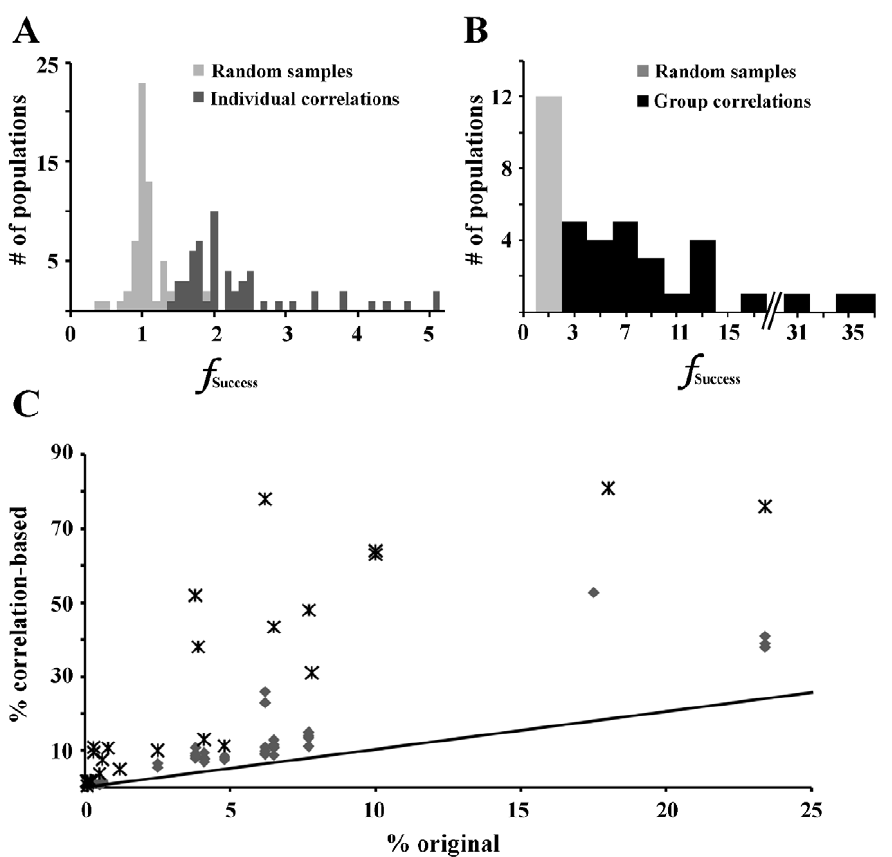
Figure 9. Correlation-based populations increased the percentage of models with a desired activity type. (A) Implementation of correlations individually had a modest, but always positive, effect on the percentage of models with the desired intrinsic activity type (%Success), contrary to the random-sample controls. Histograms are stacked in the rare case of overlap. Bin size is 0.1%. (B) Implementation of all correlations seen in an activity type increased %Success by as much as 37 fold. Bin size is 1%. (C) The percentage of a particular activity type in the original database (% original) is plotted against the percentage of models of that activity type in a correlation-based population (% correlation-based). Both single-correlation based populations (grey triangles) and multiple-correlation based populations (black stars) are shown. Unity line is shown for scale. shown in bold, and any correlation with a | r | . 0.6 is shown in red. Table S2 Conductance relationships that fit statistical criteria for correlations, but do not appear to have a linear relationship. Table S3 Percent success increased an average of 10 times the original value when model populations were defined by correla- tions. Correlation-based populations were generated using the complete set of correlations that define that activity type in the original database (See Table S1).